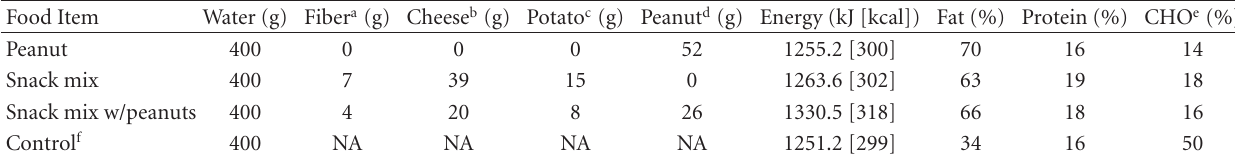
Table 3: Composition of the treatment loads.